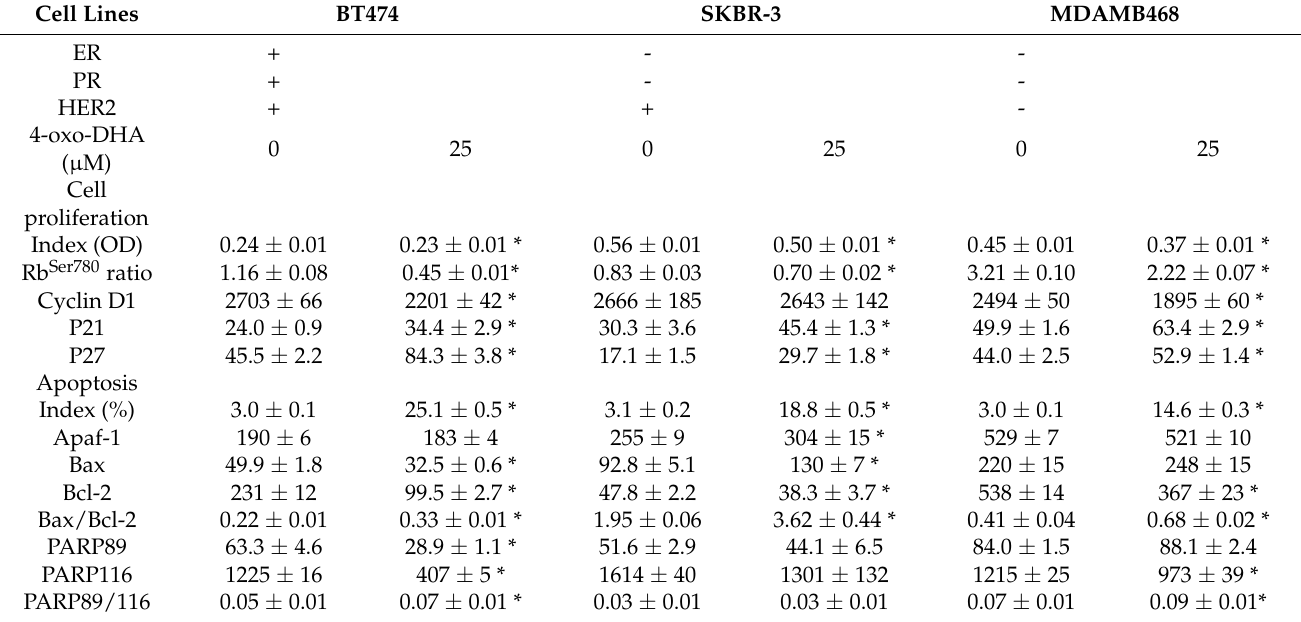
Table 1. Effect of 4-oxo-DHA on Cell Proliferation and Apoptotic Cell Death.